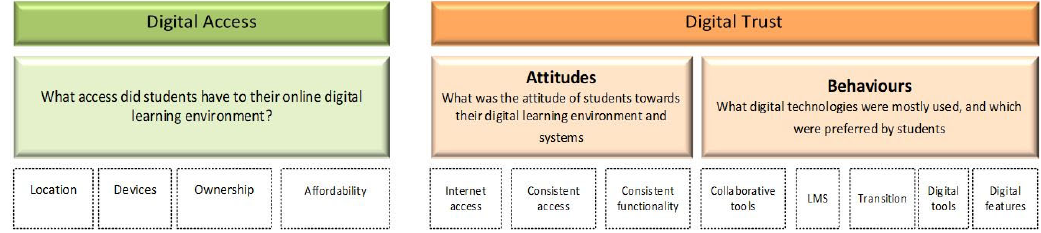
Figure 2. Research questions in relation to digital trust and digital